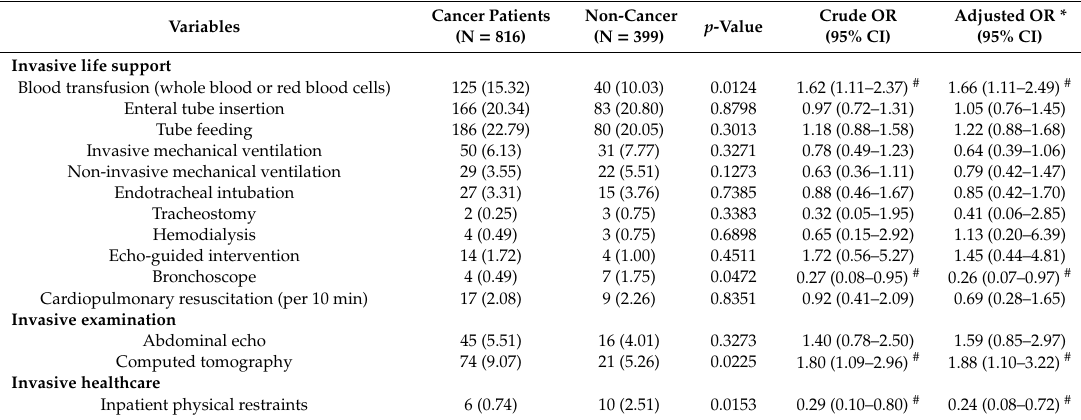
Table 3. The utilization of medical healthcare resources by COPD patients with and without cancer receiving PC during the